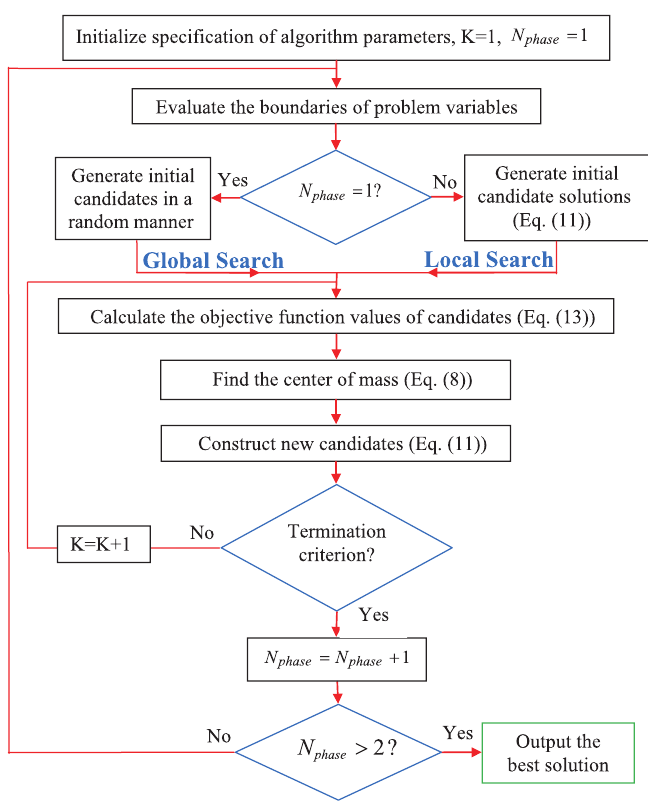
Fig. 1. Flowchart of the BB-BC